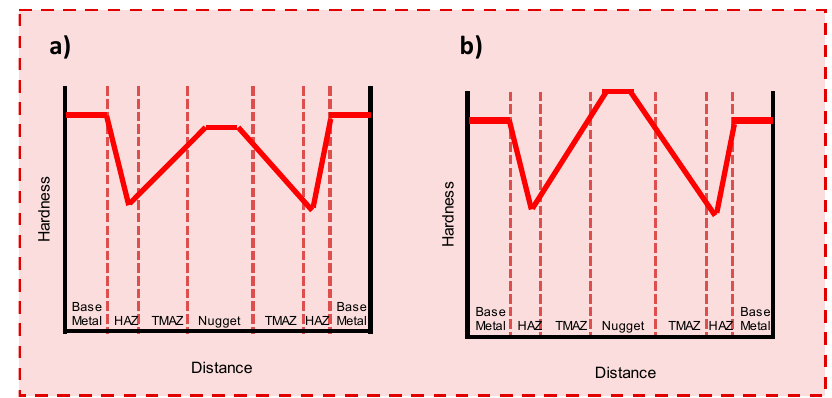
Figure 2. Hardness value distribution along a line perpendicular to the welding clad. ( a ) Distribution with base material hardness values higher than nugget hardness values. ( b ) Distribution with nugget hardness values higher than base material hardness values.